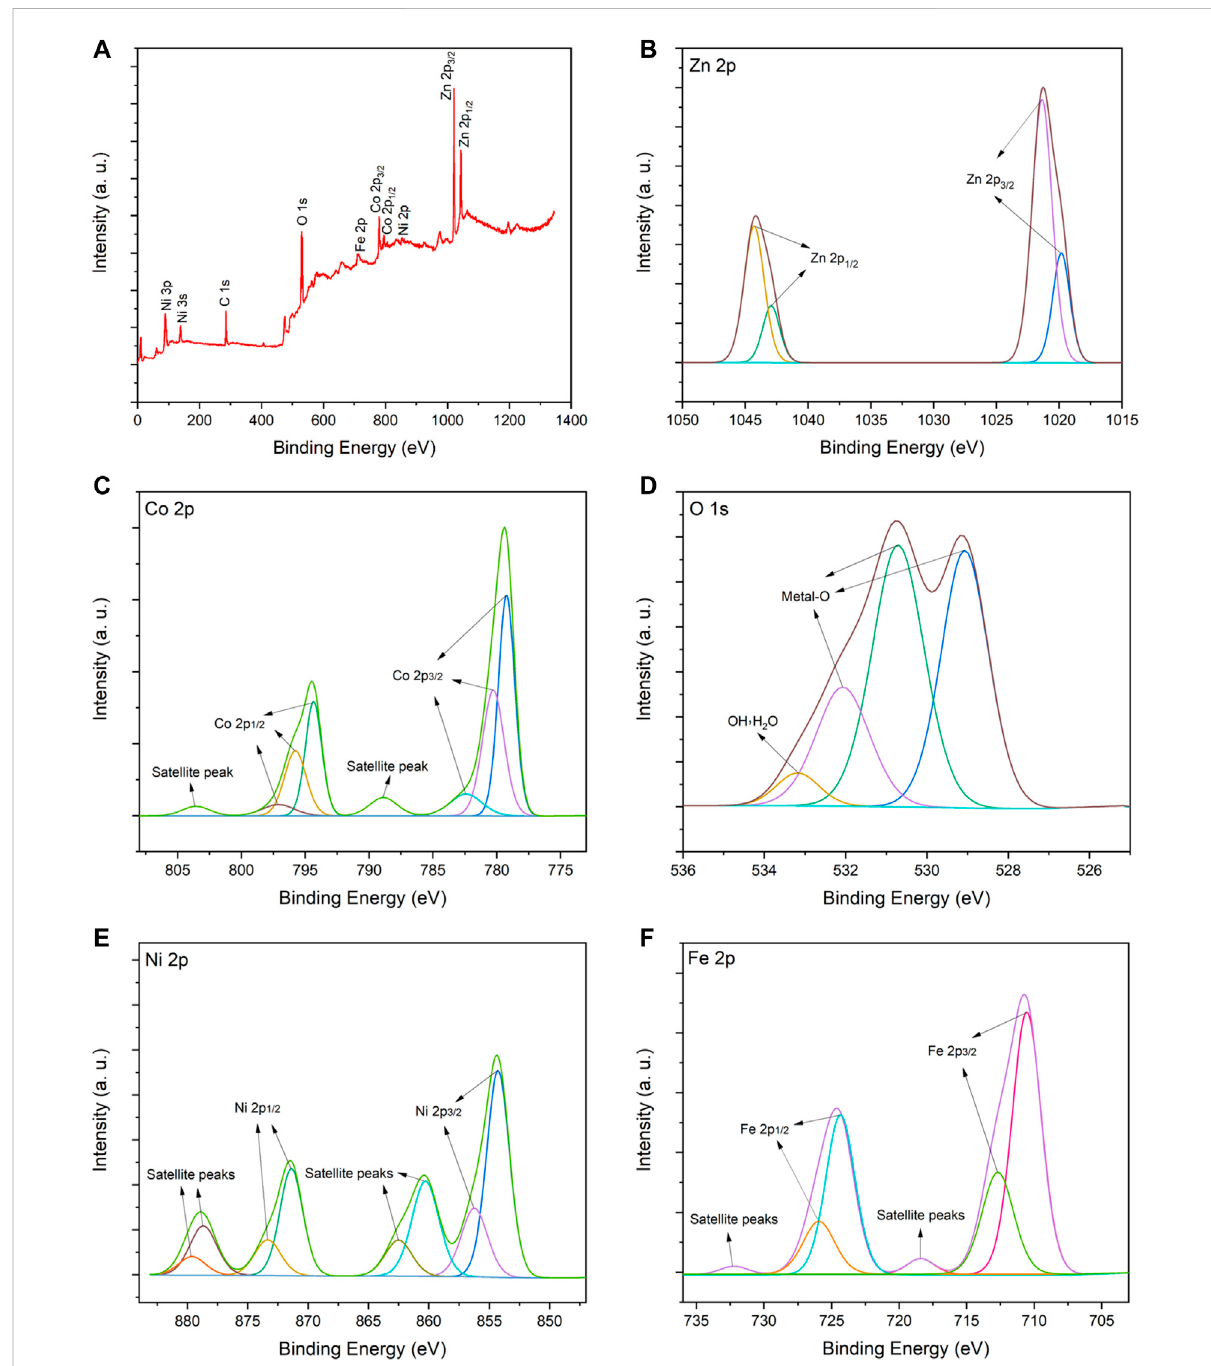
FIGURE 4 (A) XPS elemental survey spectrum, and high-resolution XPS spectra for (B) Zn 2p, (C) Co 2p, (D) O 1s, (E) Ni 2p and (F) Fe 2p of ZnO/NiFe 2 O 4 /